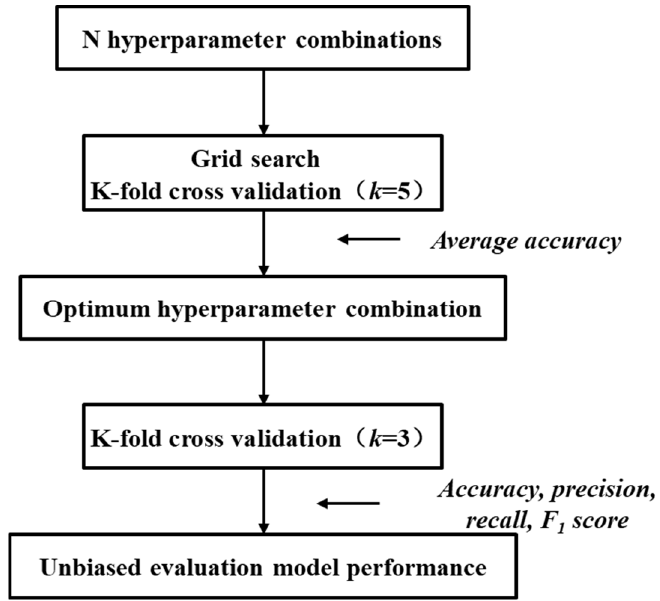
Figure 8. Model parameter optimization and evaluation process.